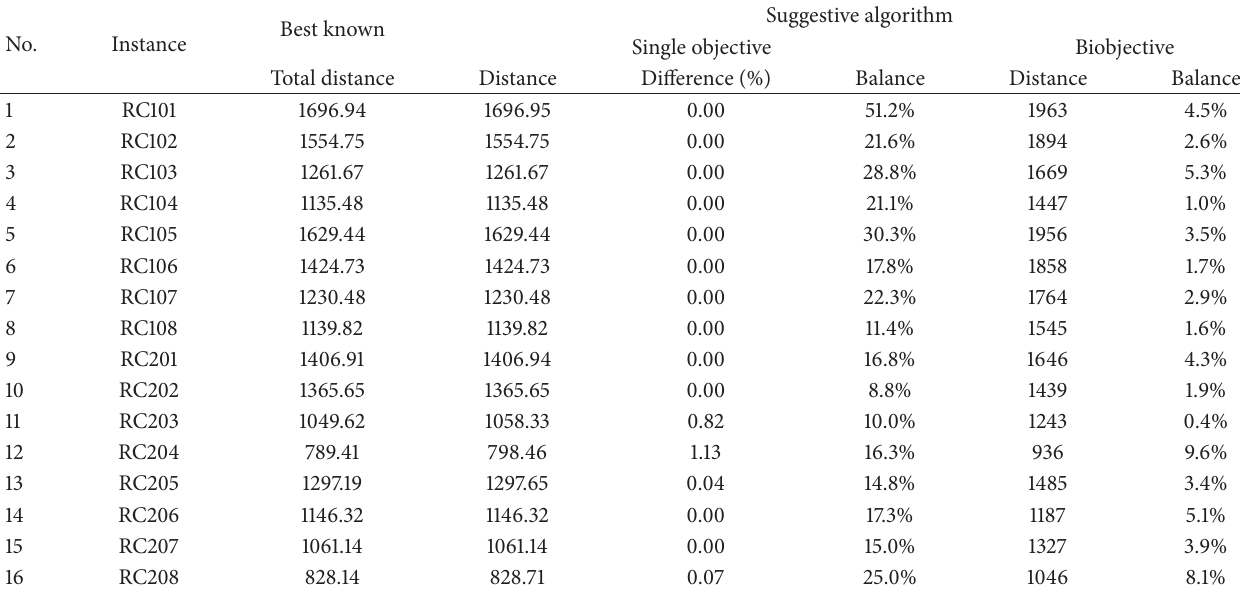
Table 3: Results of RC instances.